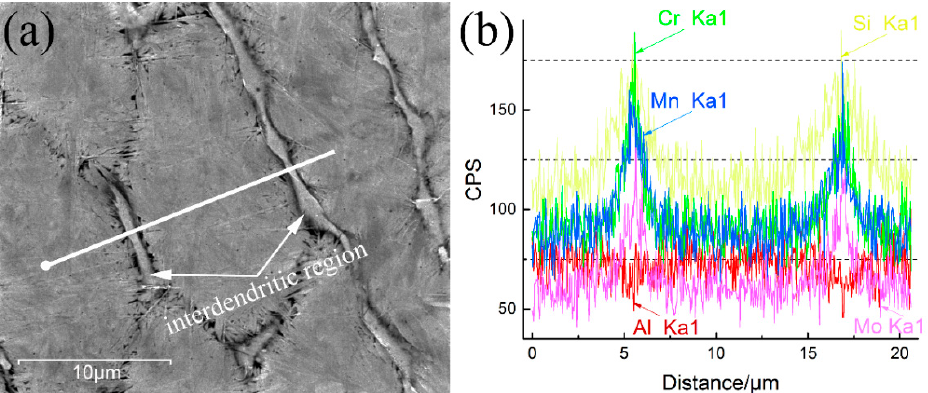
Figure 3. ( a ) A composite map of elements segregation across the interdendritic region. The white line represents the area incorporated into the vertically integrated line scanning shown in ( b ).